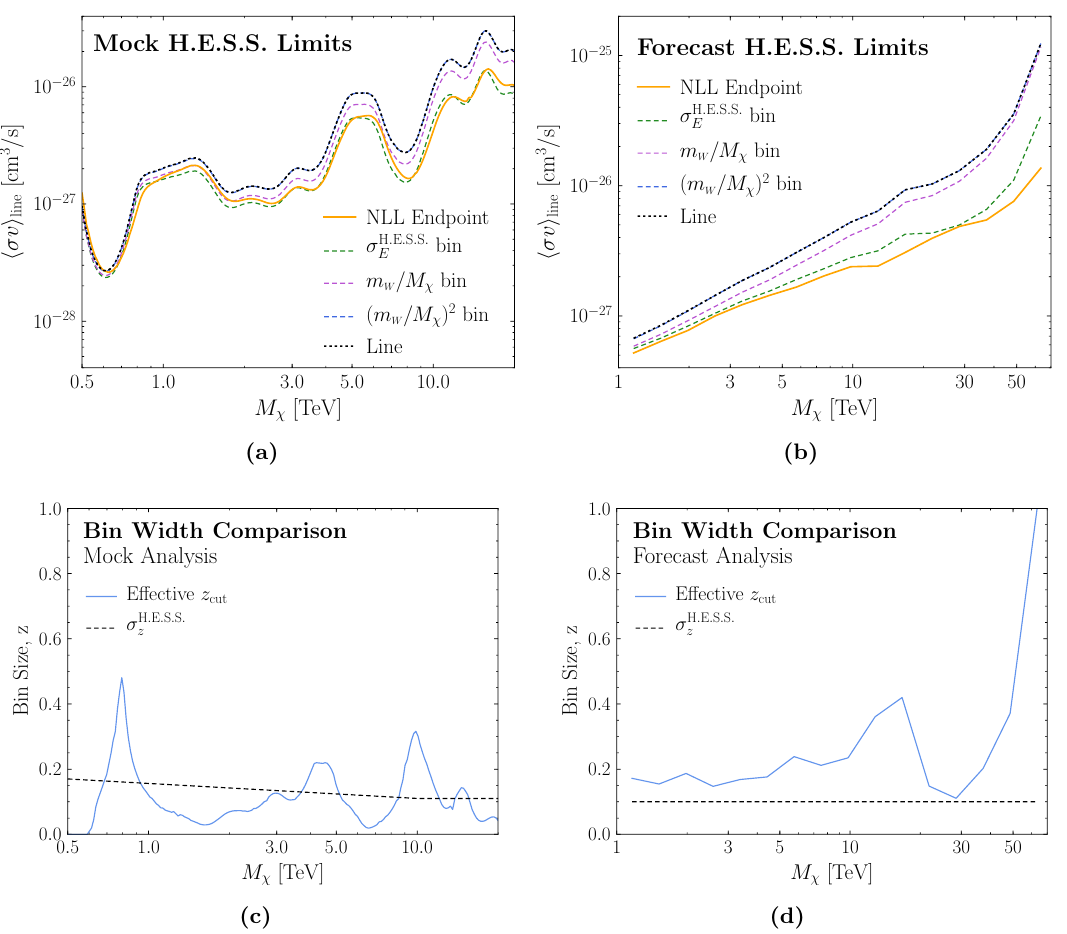
Figure 12 . (top) Estimated limits obtained using a variety of di(cid:11)erent assumptions on the treat- ment of the spectrum for the (a) mock analysis and (b) forecast analysis. The NLL endpoint curve relies on the computed spectrum, while all other curves rescale a line-only signal shape. Note that the curves corresponding to \Line" and \( m =M (cid:31) ) 2 " lie on top of each other. (bottom) The W e(cid:11)ective bin size required to reproduce the endpoint analysis, compared with the true H.E.S.S. resolution for the (c) mock analysis and (d) forecast analysis. We see that in both approaches, the bin width required to map the line-only signal onto the limit derived for the full spectral shape is a non-trivial function of the DM